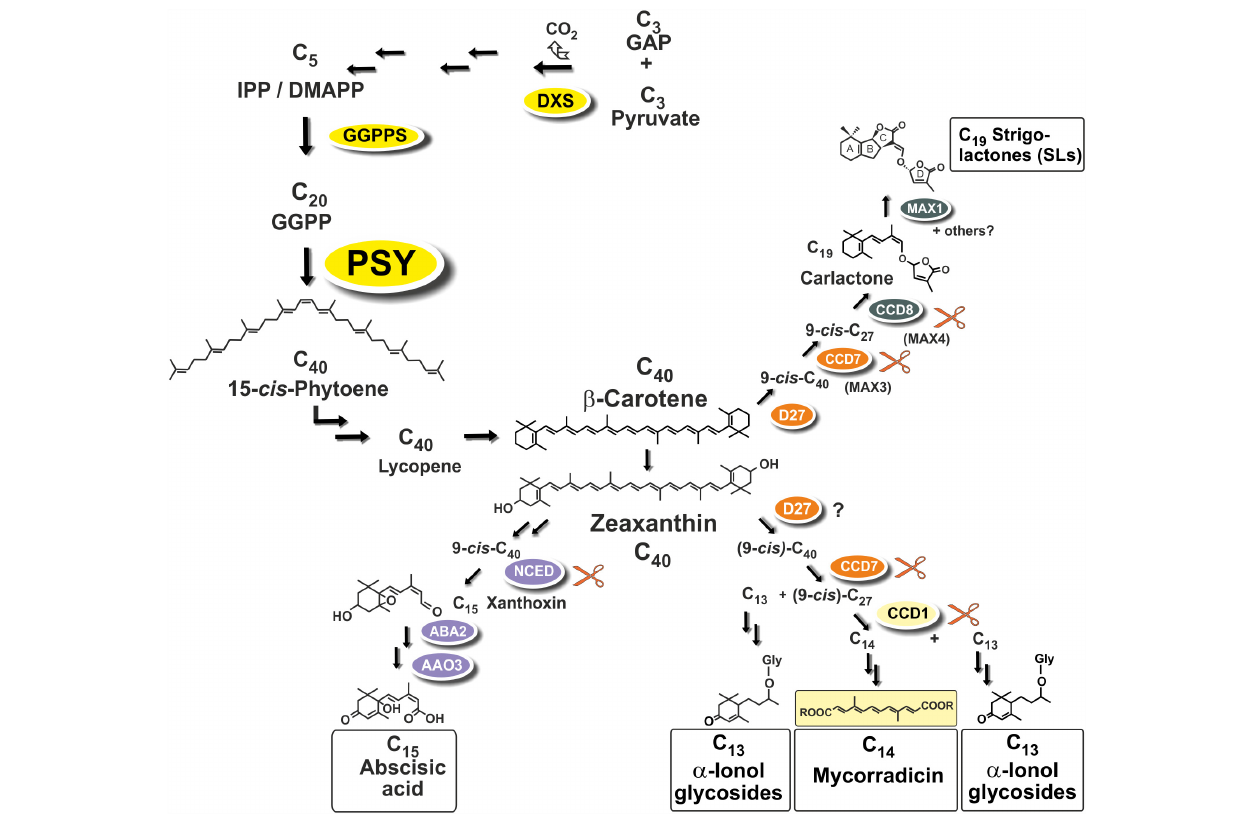
FIGURE 1 | Apocarotenoid biosynthetic pathways in roots and their carotenoid precursor supply through phytoene synthase (PSY). The simplified scheme indicates three key steps of carotenoid biosynthesis marked in yellow [1-deoxy- D -xylulose 5-phosphate synthase, DXS (MEP-pathway, horizontal arrows to the left), GGPP synthase, GGPPS, PSY, vertical arrows] and other conversions leading to β -carotene and zeaxanthin apocarotenoid precursors. Cleavage by carotenoid cleavage dioxygenases (CCDs) or 9- cis -epoxy-carotenoid cleavage dioxygenases (NCEDs) starts from 9- cis isomerized substrates by a single or by sequential double cleavage reactions followed by modification steps leading to various apocarotenoid products (boxed). A potential involvement of D27 in C 13 /C 14 apocarotenoid biosynthesis is still unresolved indicated by a question